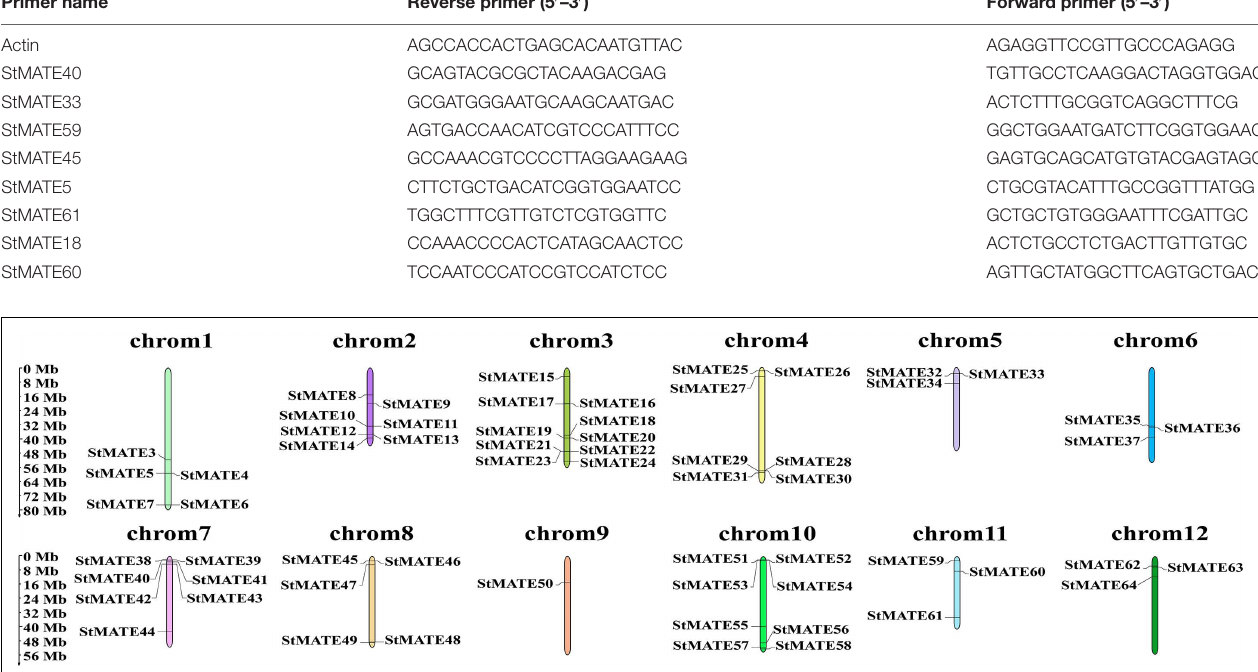
FIGURE 1 | Chromosomal distribution of StMATE genes. The scale bar on the left represents the length (Mb) of the potato chromosomes and multidrug and toxic compound extrusion (MATE) genes are marked on both the sides of the respective chromosome.